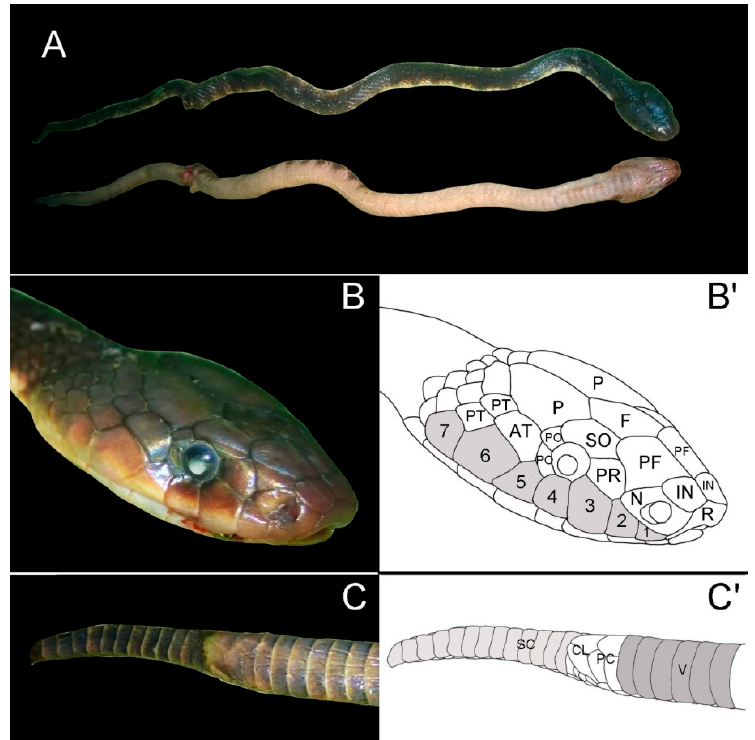
Figure 1. Photos and sketches of pertinent features confirming identification of Salomonelaps par , including: total length approximately 90 cm with a truncated tail; ( A ) dorsal and ventral body coloration and pattern consisting of dark, faintly marked patterning characteristic of Salomonelaps par ; ( B , B’ ) head scalation, with absent loreal scale, seven supralabial scales (numbered) with the third and fourth contacting the eye, two postocular scales (PO), a single preocular scale (PR), and a larger eye (compared to Loveridgelaps elapoides ); and ( C , C’ ) ventral tail scalation, with single subcaudal scales (S) (less than the specified 38 but tail appears truncated) and a paired cloacal plate (CL) in contrast to Loveridgelaps elapoides , which has a single cloacal plate and divided subcaudals. Figure prepared by Mark O’Shea from original images supplied by the authors.